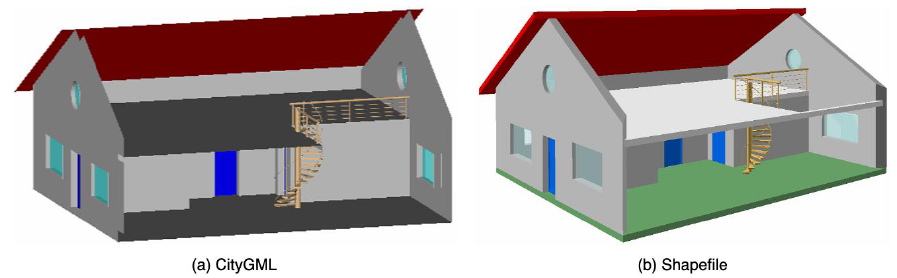
Figure 2. A house model in ( a ) CityGML and ( b ) Shapefile.